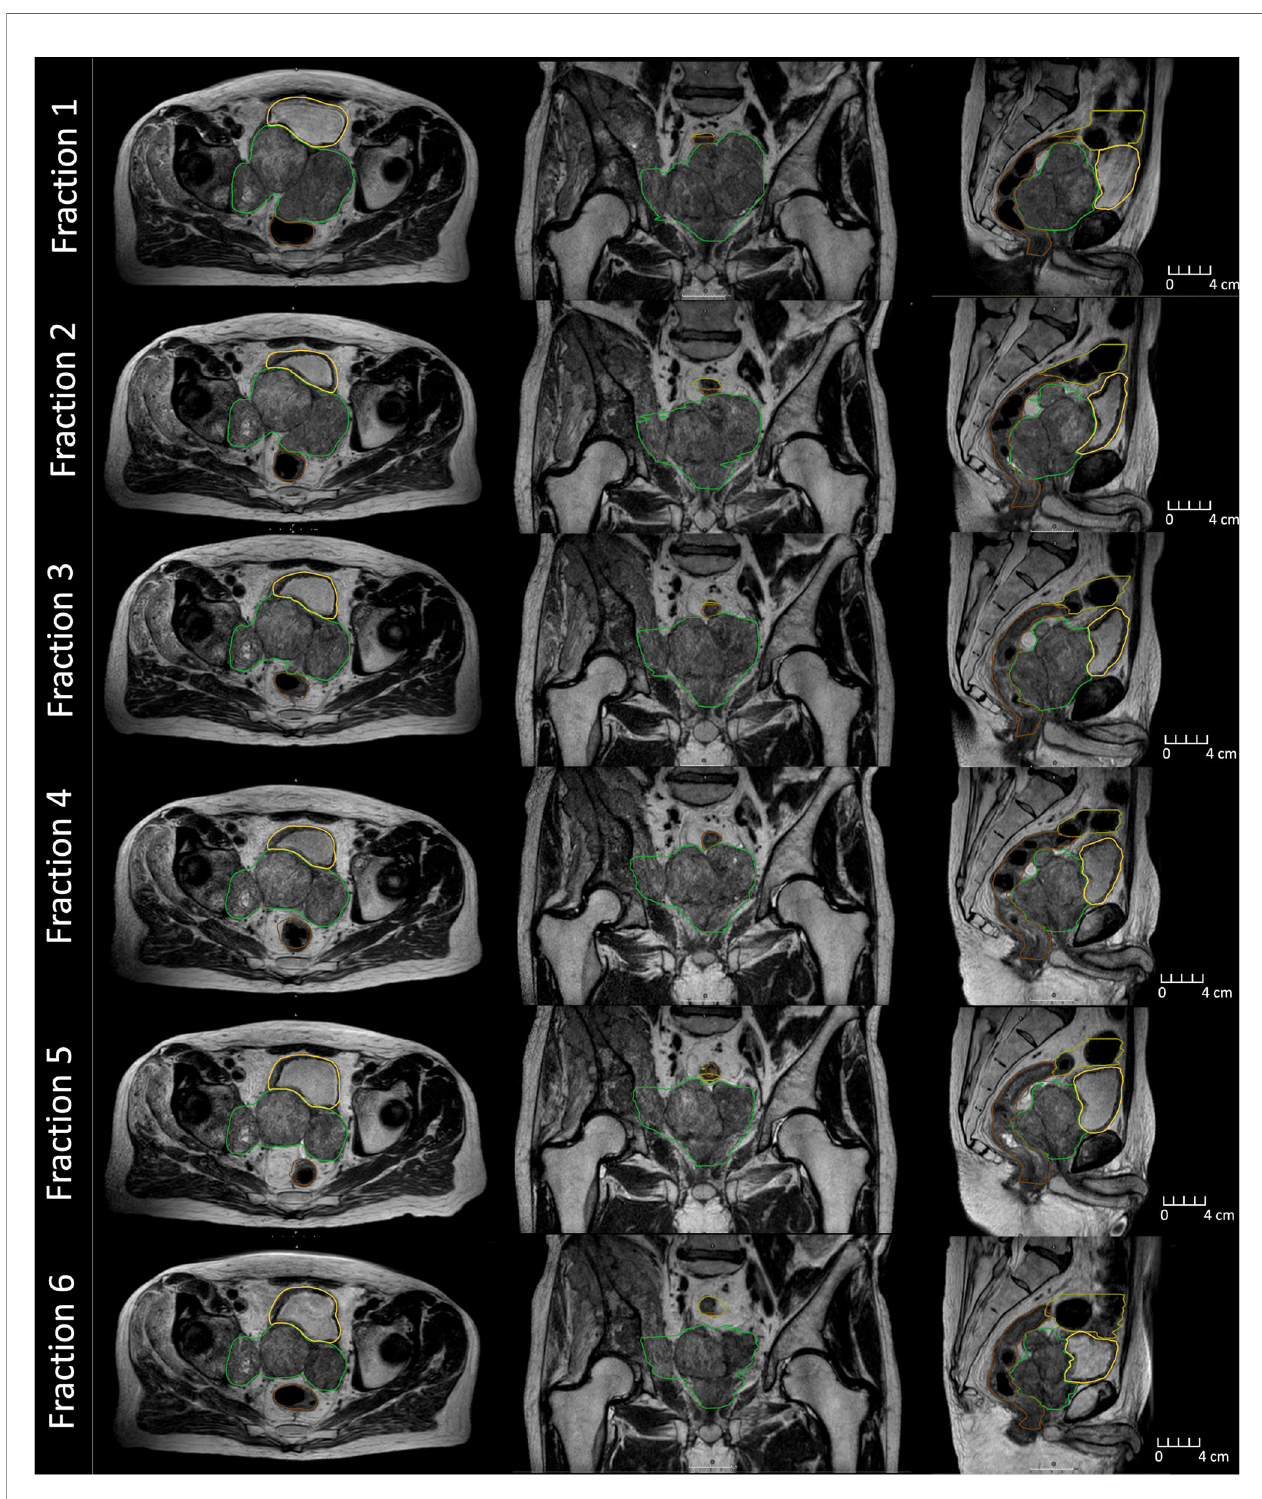
FIGURE 2 | MR images collected during beam delivery for each fraction on the MR-Linac during treatment. Displayed is the clinical target volume (green), rectum (brown), bladder (yellow), and large bowel (olive).